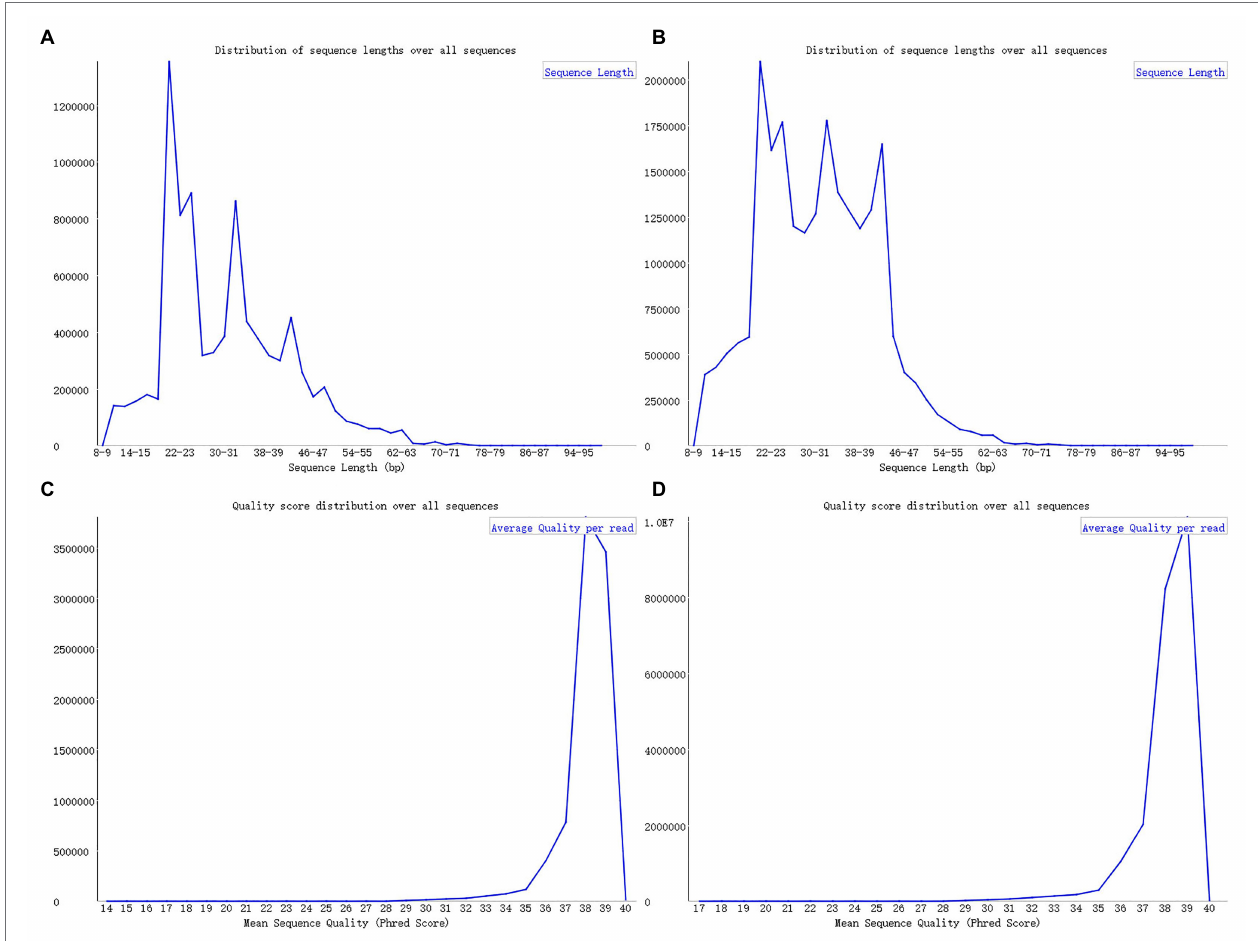
FIGURE 3 | FastQC sequence evaluation results. (A) The sRNA data of the blank group of soybeans without quality control. (B) The sRNA data of the experimental group infected by Phytophthora sojae without quality control. The abscissa in the figure signifies the sequence length and the ordinate indicates the number of sequences. (C,D) The corresponding quality control results. The ordinate represents the number of sequences, while the abscissa denotes the average base quality of the sequences.